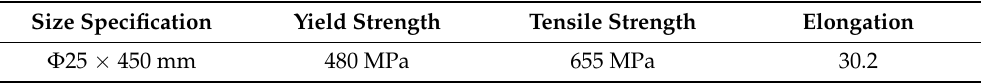
Table 5. Tensile performance of clad